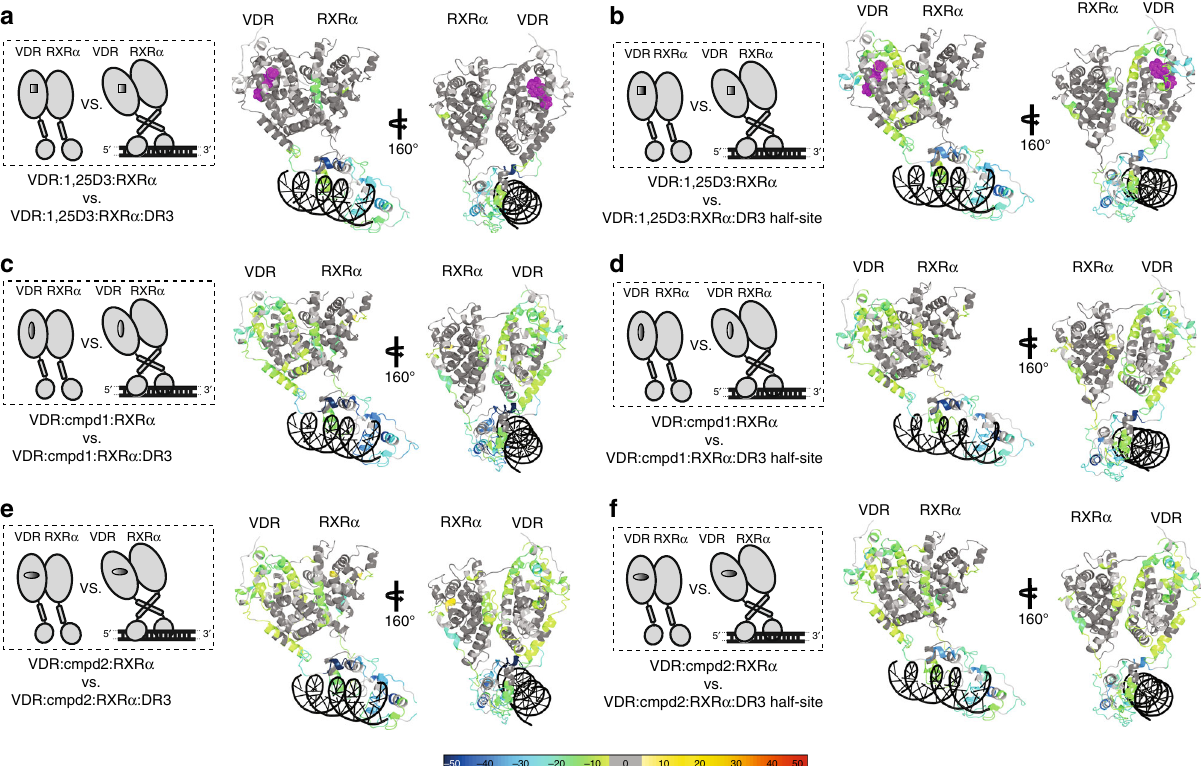
Fig. 3 Comparisons of DR3 and DR3 half-site binding effects on natural agonist- and synthetic-agonist- bound heterodimer complexes. Schematic representations illustrate differential experiments of VDRRXR α : ligand complex verse VDRRXR α : ligand: DNA complex (on the left). Consolidated differential HDX data are mapped onto the VDRRXR α heterodimer structure model in ribbon when the complex is bound to different ligands and DNA VBS (on the right). Conformational changes of 1,25D3-bound heterodimer upon binding of a DR3 (Supplementary Fig. 1b, d, column (v)) and b DR3 half-site (Supplementary Fig. 1b, d, column (vi)). Conformational changes of Cmpd1 bound heterodimer upon binding of c DR3 (Supplementary Fig. 1b, d, column (vii)) and d DR3 half-site (Supplementary Fig. 1b, d, column (viii)). Conformational changes of Cmpd2 bound heterodimer upon binding of e DR3 (Supplementary Fig. 1b, d, column (ix)) and f DR3 half-site (Supplementary Fig. 1b, d, column (x)). Percentages of deuterium differences are coded as Fig. 1. Dark gray, no statistically signi fi cant changes between compared conditions; light gray, regions that have no sequence coverage and include proline residue that has no amide hydrogen exchange activity; purple, 1,25D3 ligand; black, DNA